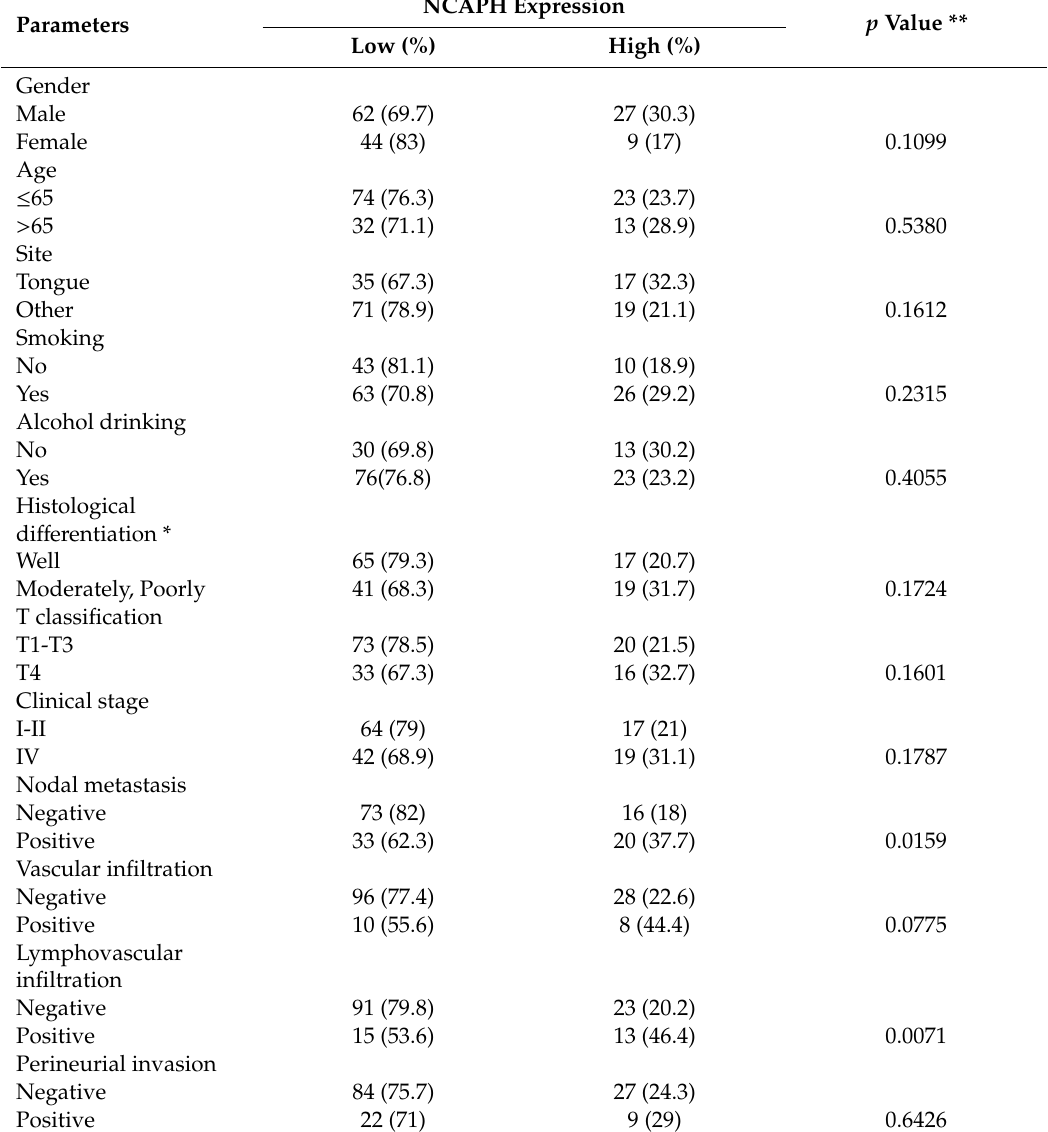
Table 1. Relationship between NCAPH expression and clinicopathological